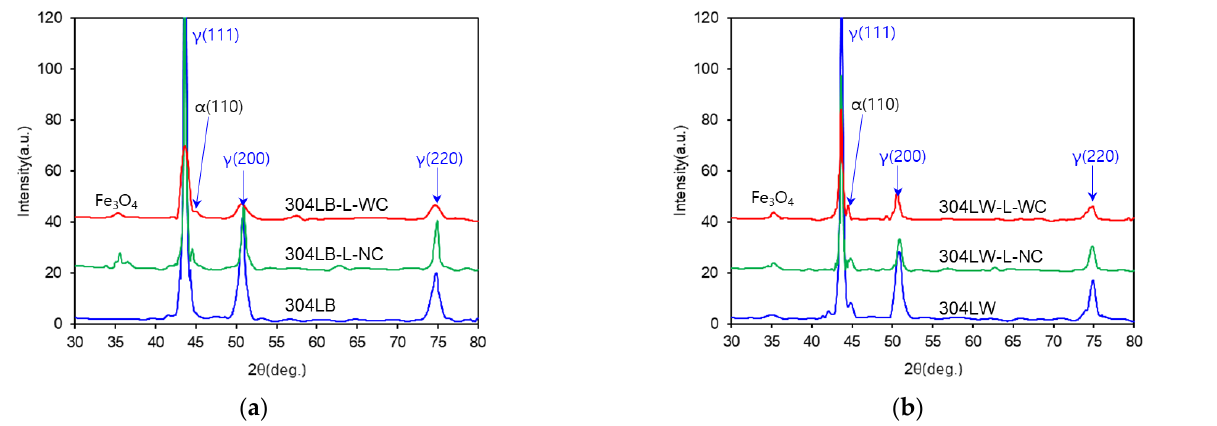
this work. this work.